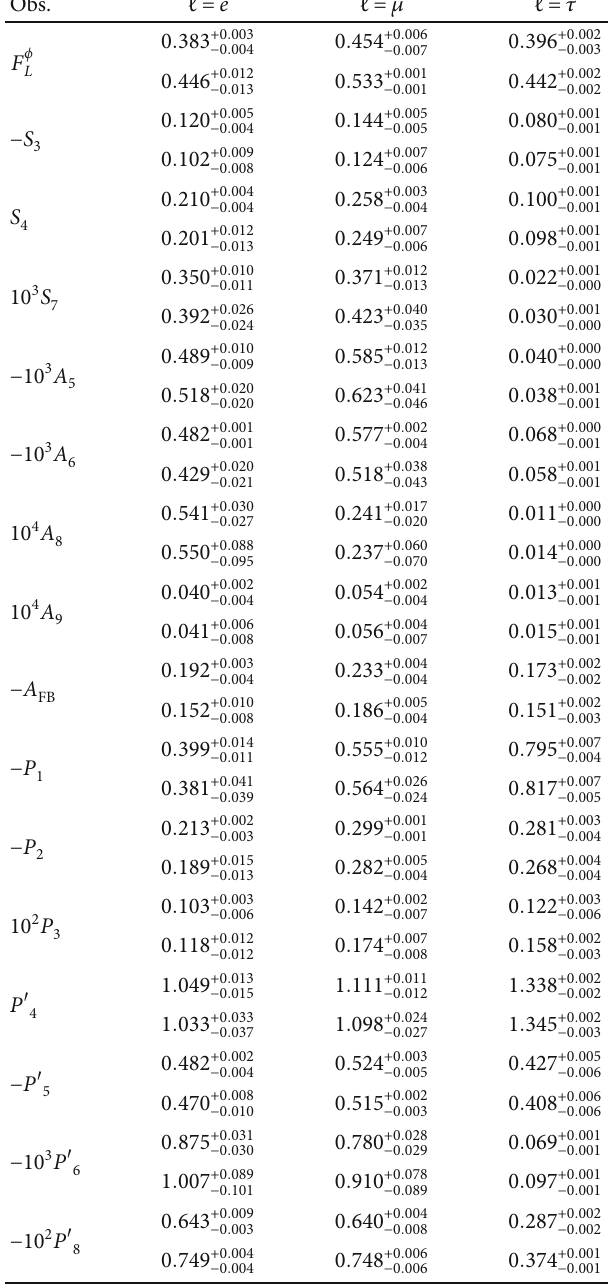
Table 7: Theoretical predictions for the observables F ϕ A 5,6,8,9 , P 1,2,3 , and P 4,5,6,8 ′ integrated over the whole kinematic region ⟶ ϕ ℓ + ℓ − decays in the PQCD (the fi rst row) and “ PQCD for B s +Lattice ” (the second row) approaches, respectively.